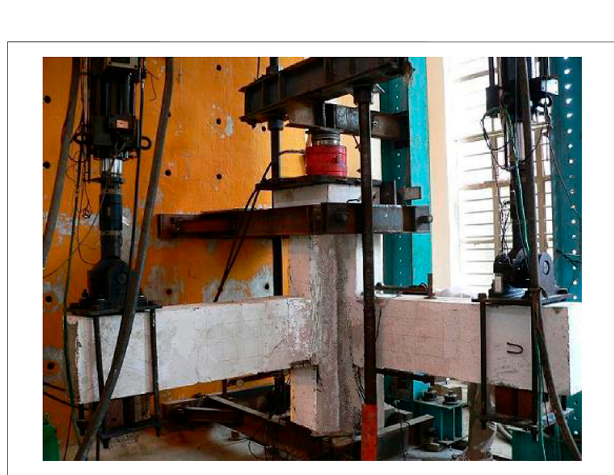
FIGURE 14 | Test fi eld loading devices (Xiang et al., 2017; Xiang et al., 2019).